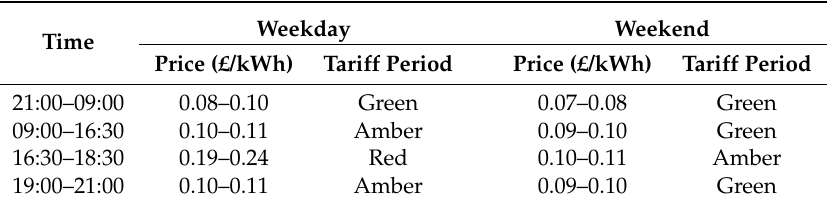
Table 2. Electricity tariff